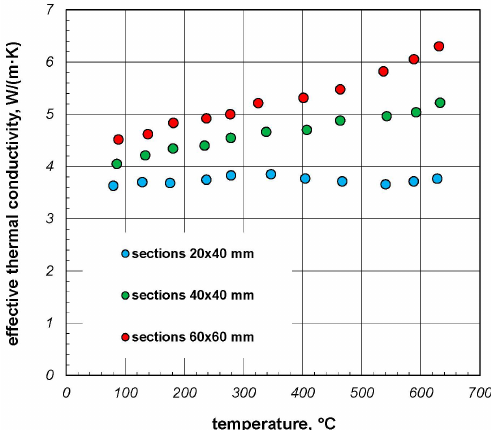
Figure 9. The effective thermal conductivity of rectangular section samples depending on the temperature and section